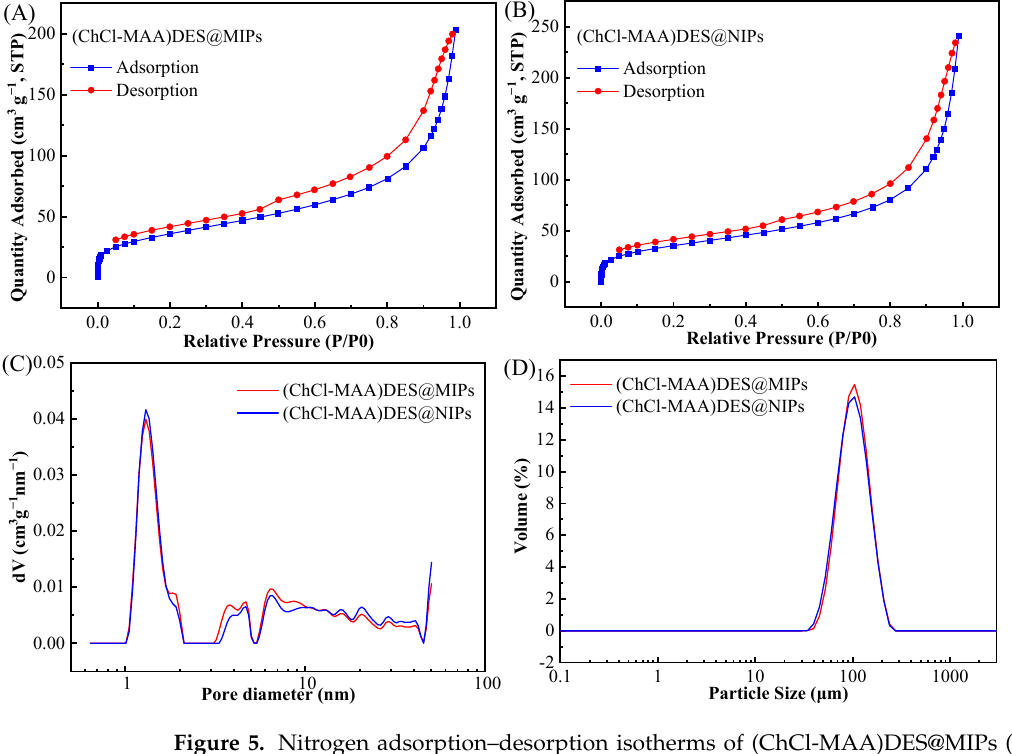
Figure 5. Nitrogen adsorption–desorption isotherms of (ChCl-MAA)DES@MIPs ( A ) and (ChCl-